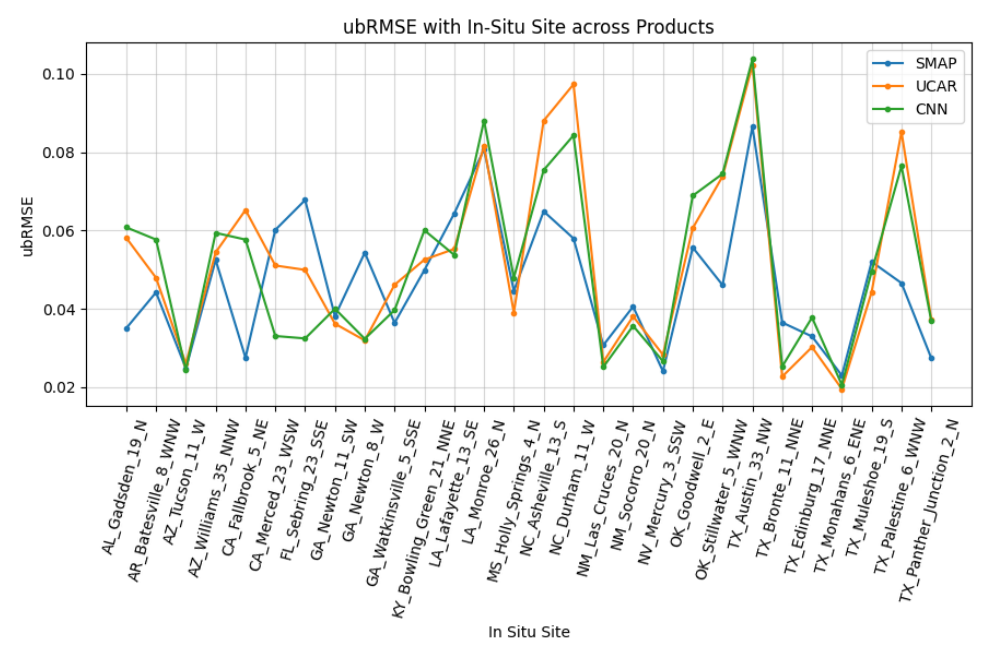
Figure 20. Average ubRMSE for the validation window calculated for each of the three remotely sensed products at the USCRN stations.